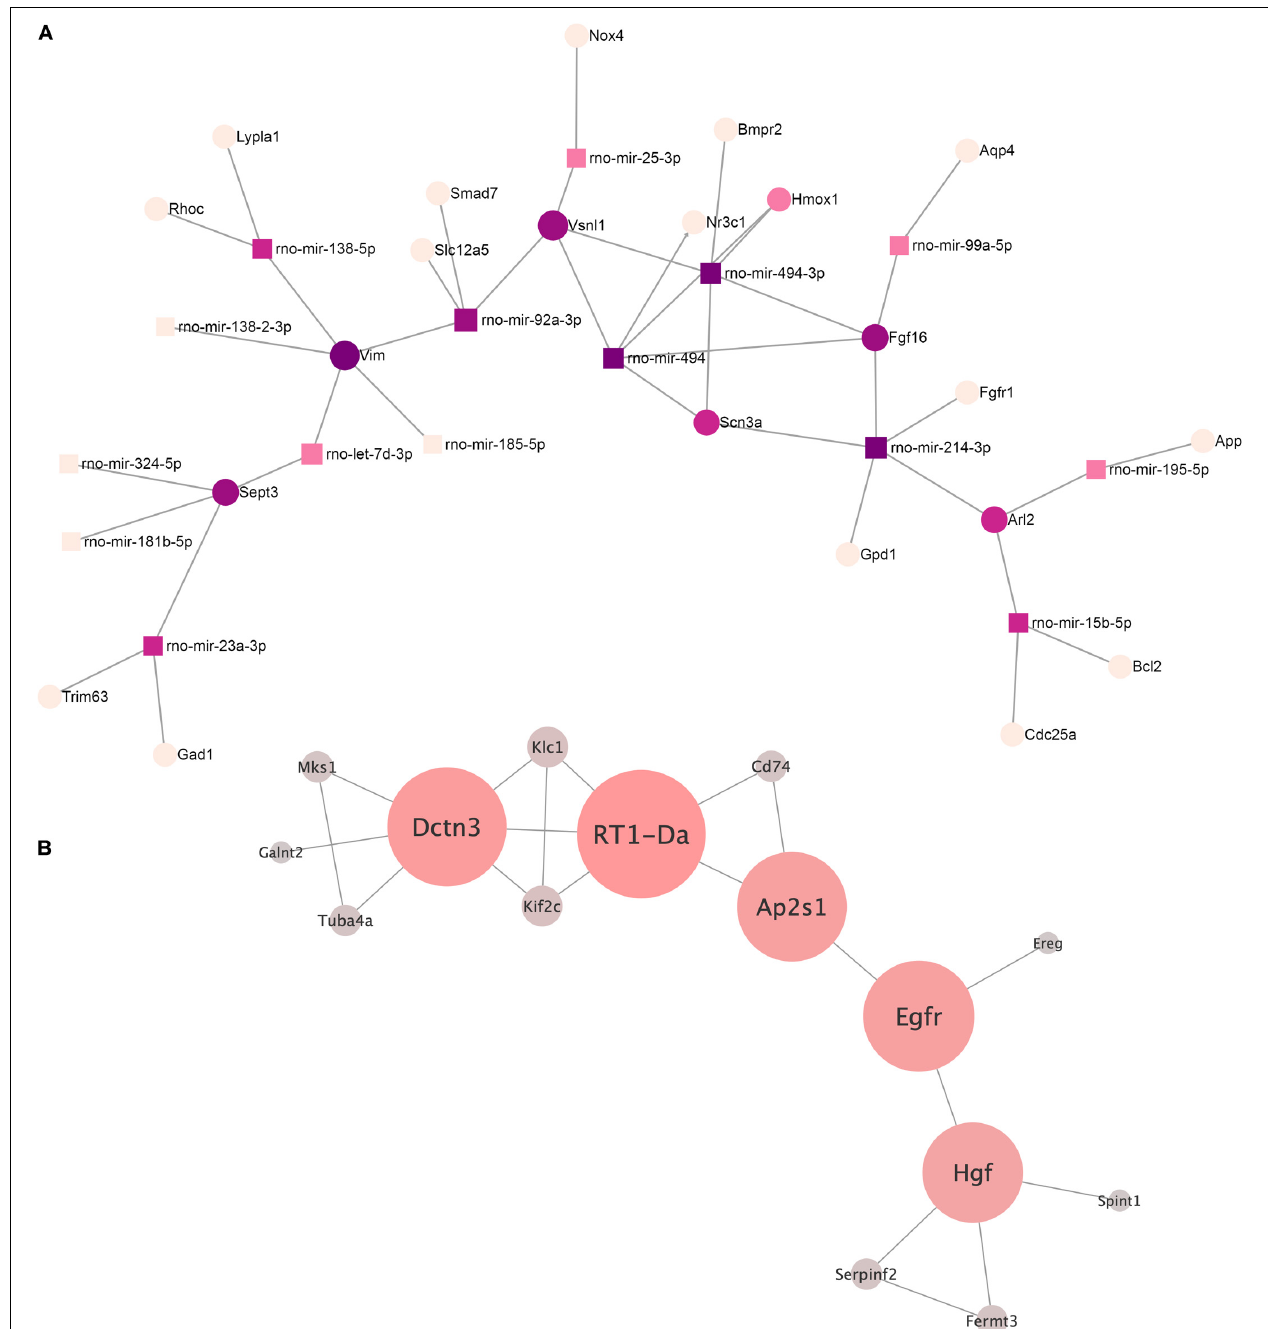
FIGURE 4 | (A) The microRNA–target gene interaction network of the differentially expressed miRNA (log2 fold change ≥ 2.0, ≤ –2.0) was constructed using the miRNet 2.0 network-based visual analytic tool. Nodes indicated by rectangles represent signature miRNAs. Nodes indicated by circles represent target genes including violet nodes representing “hub” genes, regulated more than four miRNAs. (B) Network of rno-miRNA-128-3p targeted gene intermolecular interactions. The color gradient from gray to red and the size shows the centrality of the